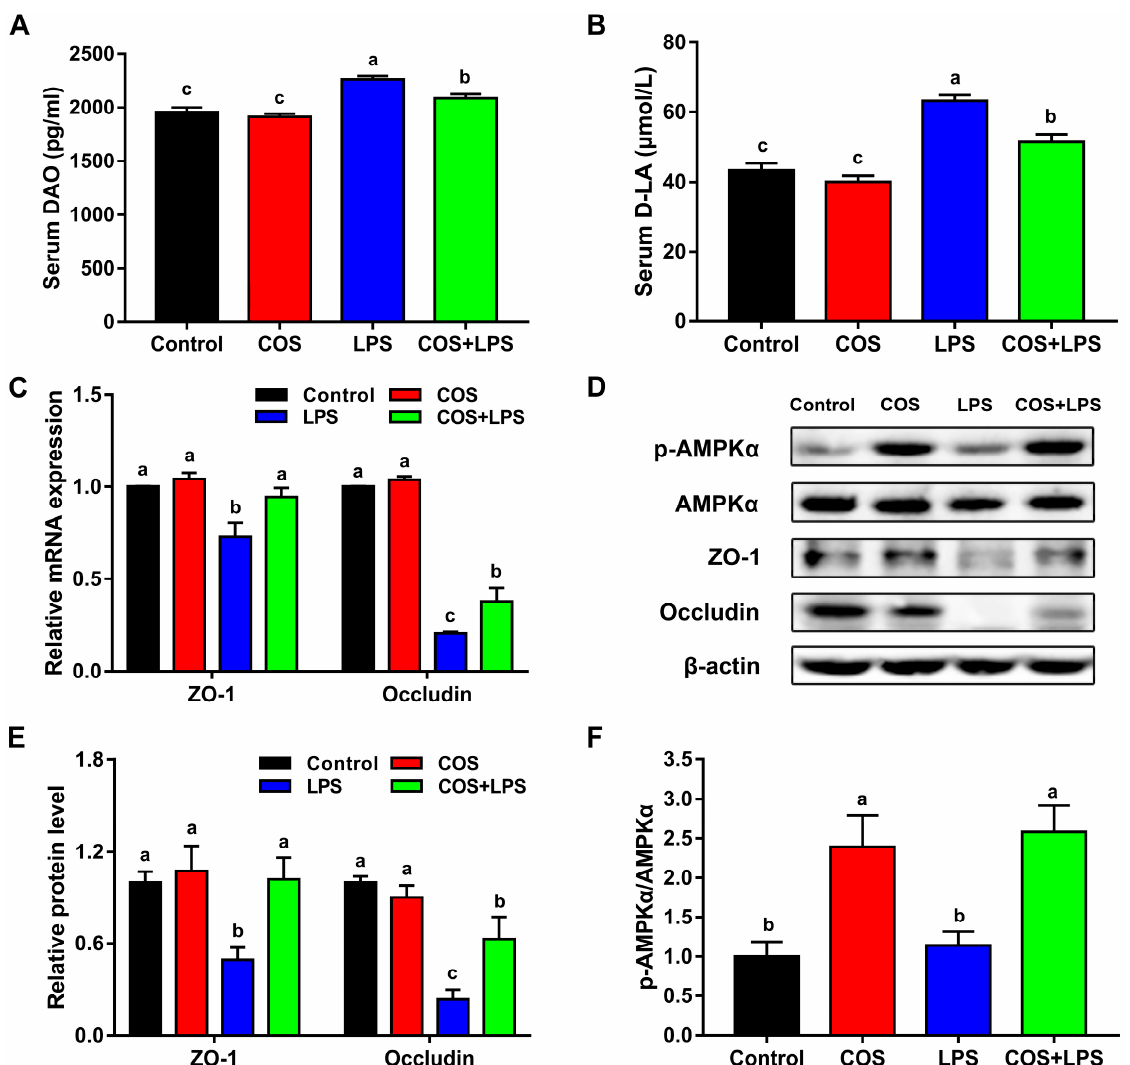
Figure 4. Effects of COS on intestinal permeability and intercellular junctions in mice. The level of DAO ( A ) and D-LA ( B ) in serum, n = 8. ( C ) The relative mRNA expression of ZO-1 and Occludin in the jejunum, n = 6. ( D ) Western blot analysis of ZO-1, Occludin, p-AMPK and AMPK protein expression in the jejunum. The density identification of ZO-1 and Occludin ( E ) and AMPK ( F ), n = 6. The data are presented as the mean ± SE. Values without a common letter are significantly different ( p < 0.05). COS, chitosan oligosaccharide; LPS, Lipopolysaccharide; DAO, diamine oxidase; D-LA, D-lactate; ZO-1, Zonula occludens 1; and AMPK α , adenosine monophosphate-activated protein kinase α .